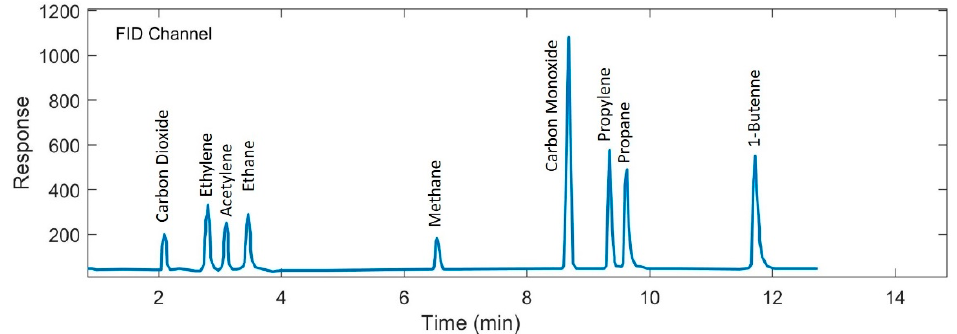
Figure 6. Gas Chromatography result.